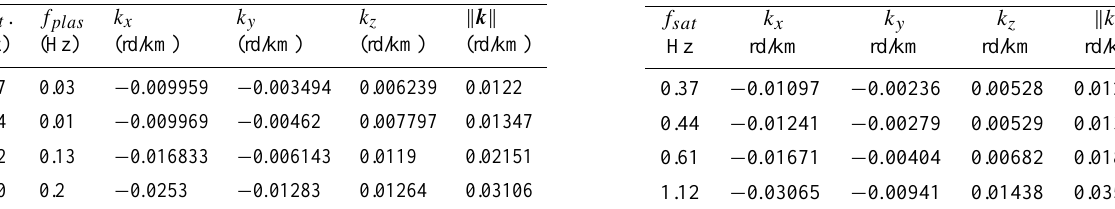
Table 1. Wave vectors ( k ) computed for the four frequencies being investigated using the phase differencing method.